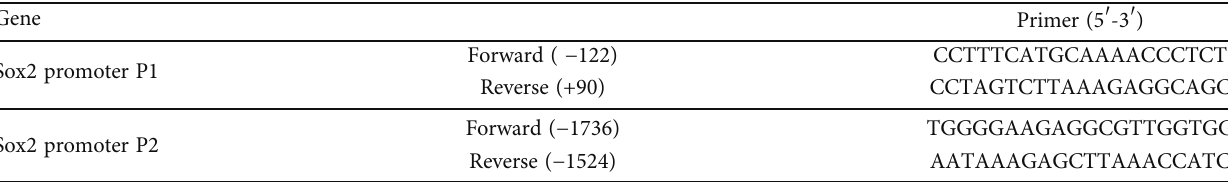
Table 1: Nucleotide sequences of ChIP assay PCR primers.